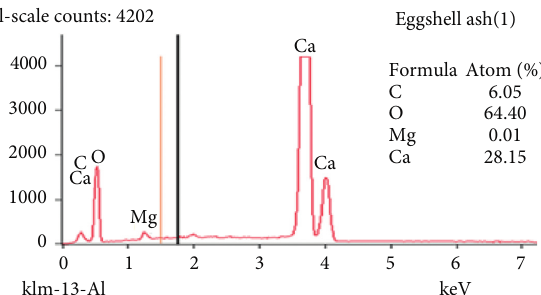
Figure 8: SEM-EDX spectrum of chicken eggshell ash-derived CaO which were calcined at 800 ° C.